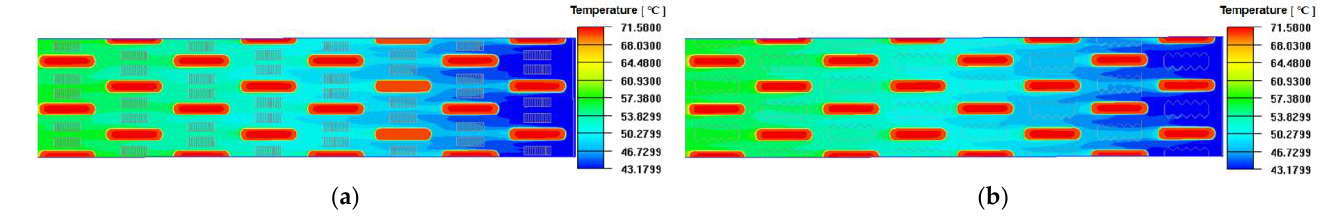
Figure 7. Temperature cloud map in the basin before and after improvement; ( a ) original model; ( b ) improved model.